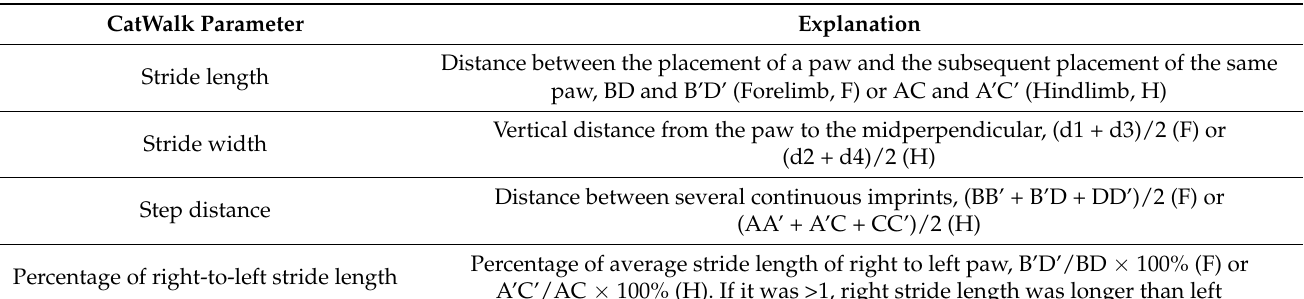
Table 1. Explanation of CatWalk parameters. CatWalk Parameter